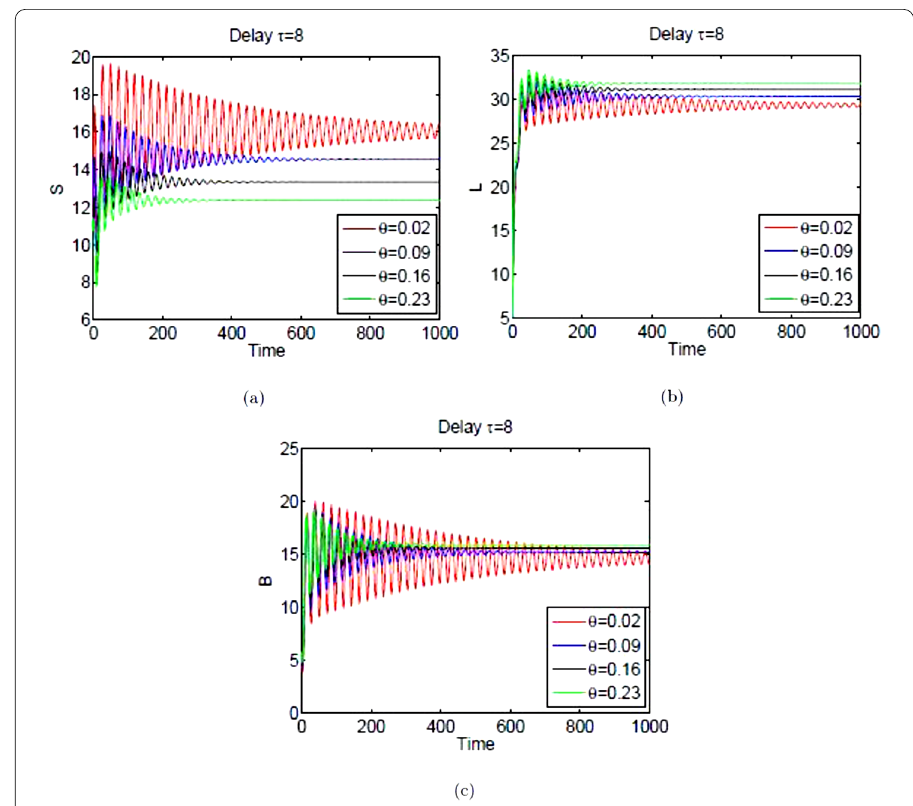
Figure 5 Effect of infected rate at which uninfected computers are infected due to the influence of infected removable storage media ( θ ) ( a ) uninfected/susceptible node, ( b ) latent node, and ( c ) breaking-out node with τ = 8. The values of other parameters are as in